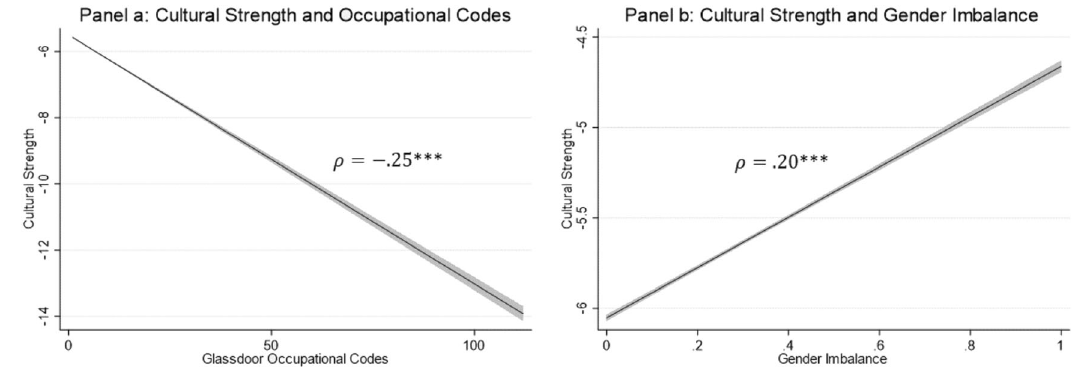
Fig. 4 Exploratory analysis of additional covariates of cultural strength (computed on “ pros ” ). In Fig. 4, we report results from bivariate analysis showing the correlation of cultural strength with variables selected for exploratory purposes. + p < 0.1; * p < 0.05; ** p < 0.01; *** p <